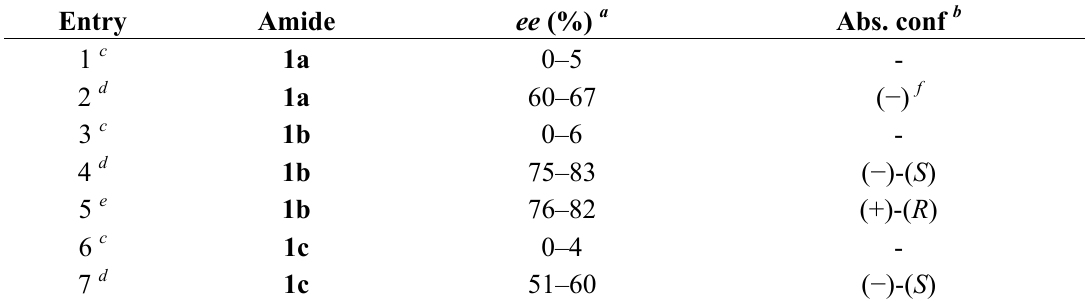
Table 1. Deracemization of racemic nicotinamides 1a – c by salt formation with ( − )- L -DBTA.